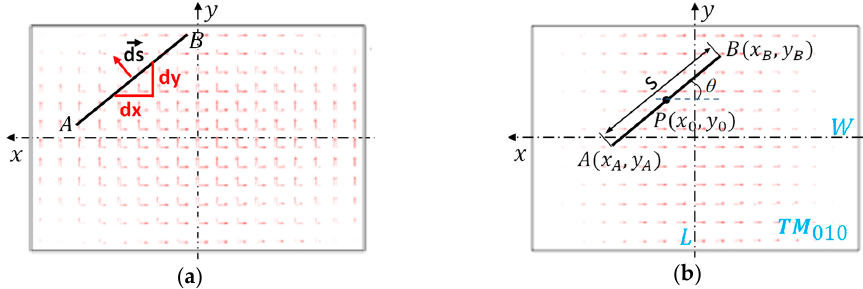
Figure 7. Definition of crack’s cutting effect intensity ϕ on the antenna current. ( a ) definition; ( b ) calculation of ϕ 010